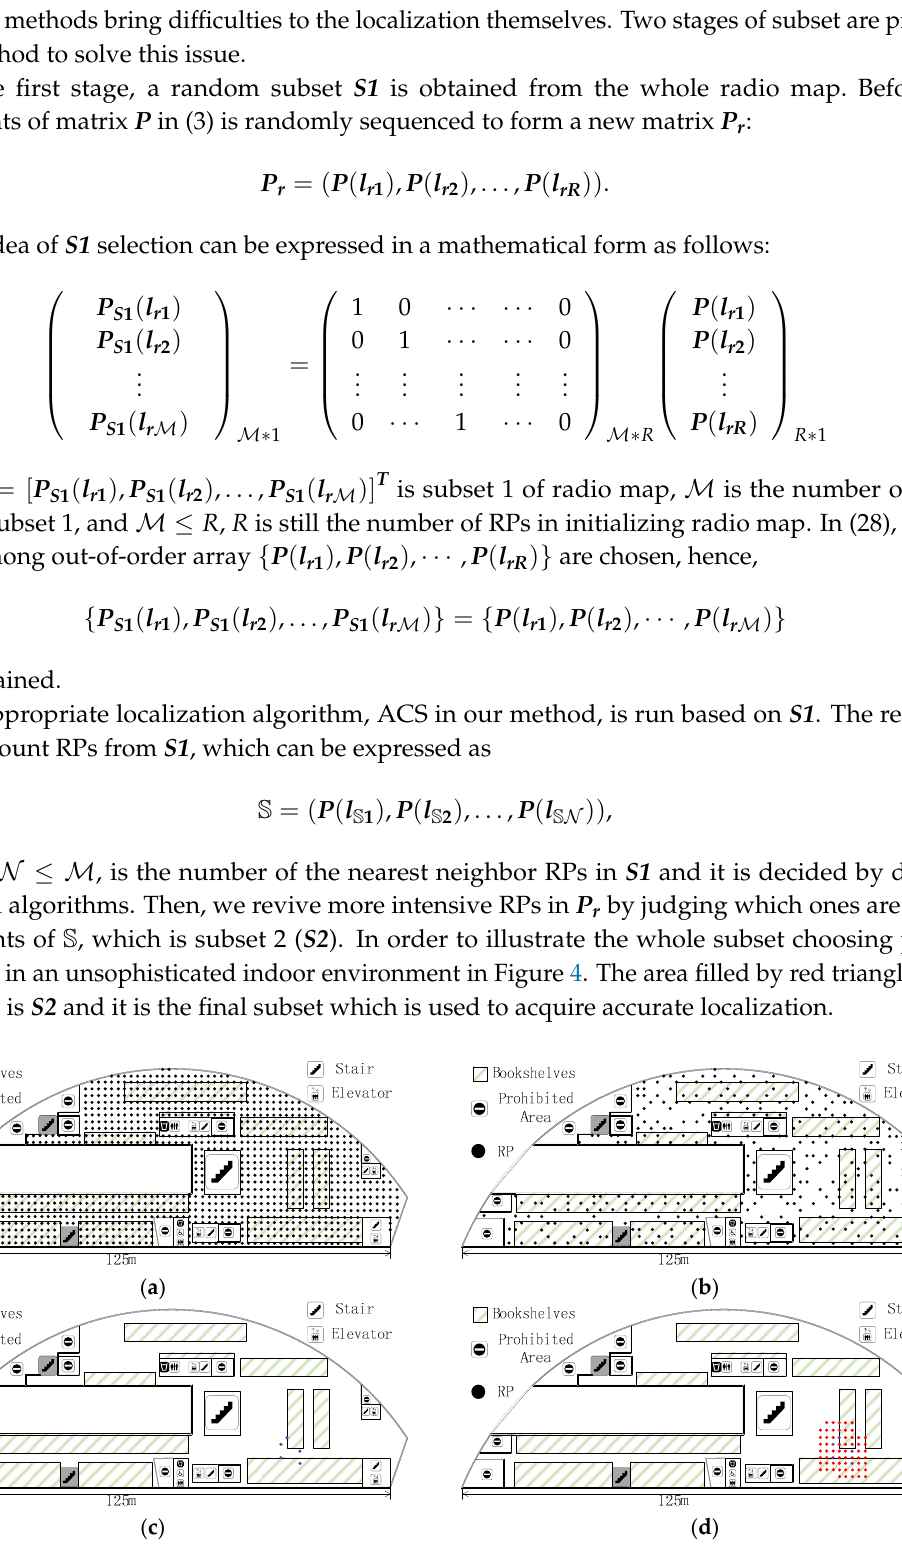
Figure 4. The process of choosing radio map subset. ( a ) The original reference points (RPs) in an indoor environment, which are shown as black circle dots; ( b ) Subset S1 is shown as purple circle dots; ( c ) In the online phrase, five localization RPs in S1 ; ( d ) Subset S2 is shown as red triangles.